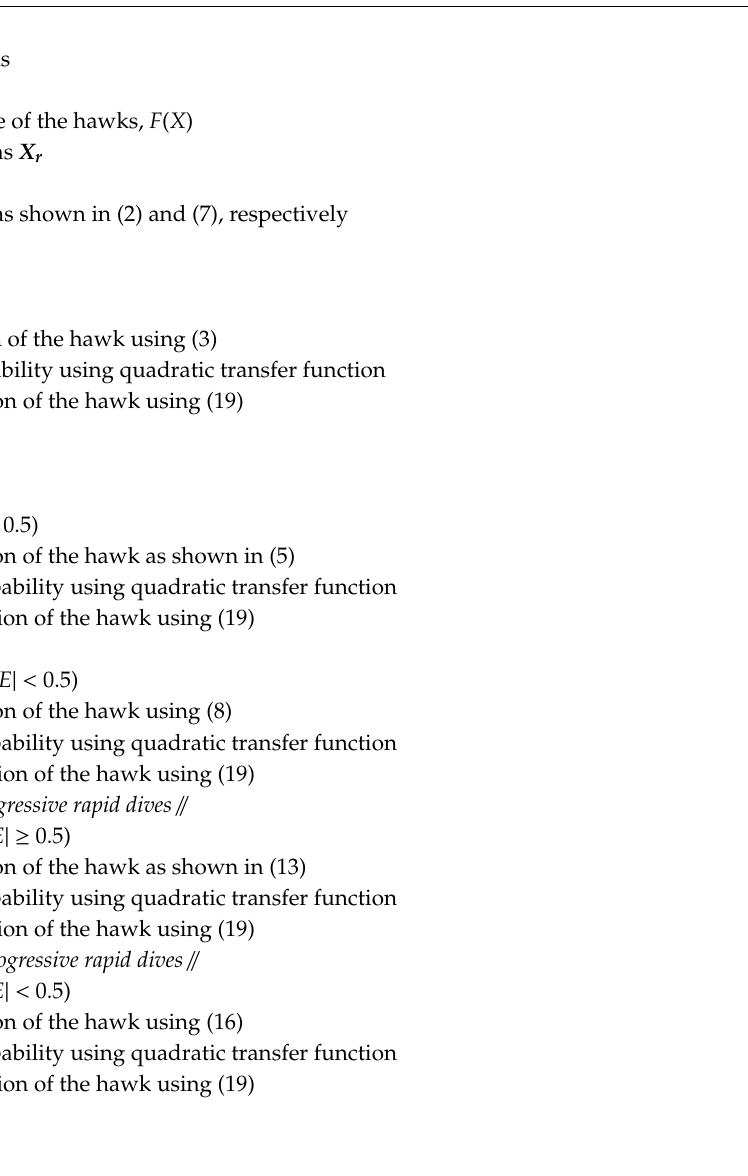
Algorithm 2. Quadratic binary Harris hawk